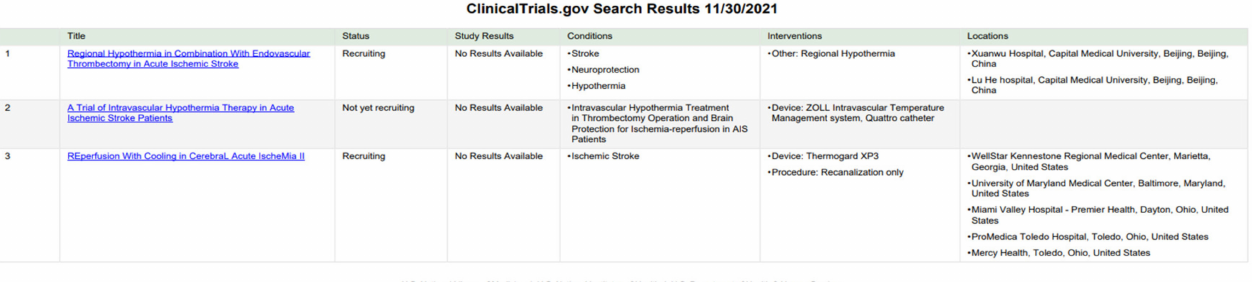
Figure 6. Clinical trials for Hypothermia/Cooling interventions in acute ischemic stroke on https: //clinicaltrials.gov (accessed on 16 December 2021).